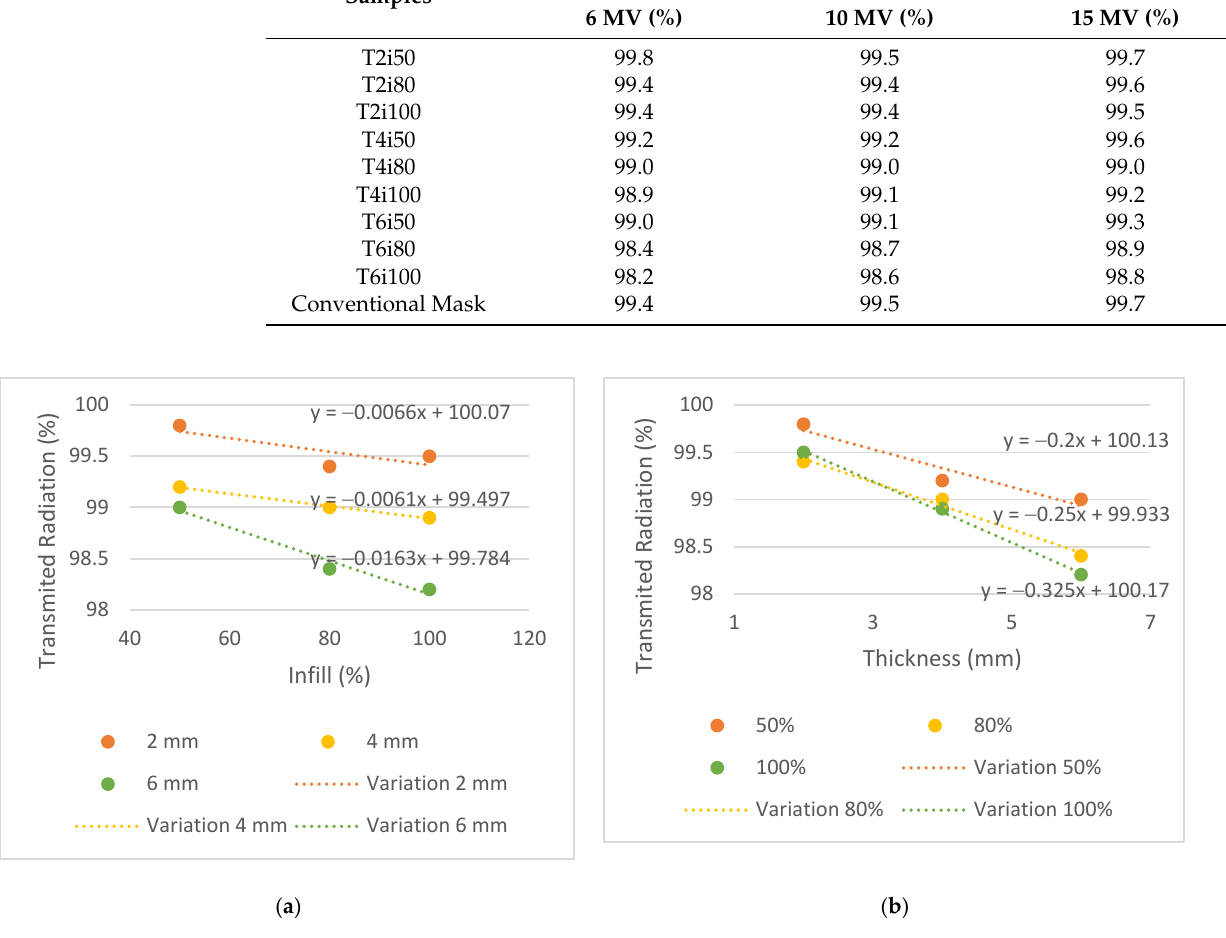
Figure 6. Variation of the transmitted radiation, in %, for the energy of 6 MV, ( a ) by infill and ( b ) by thickness.